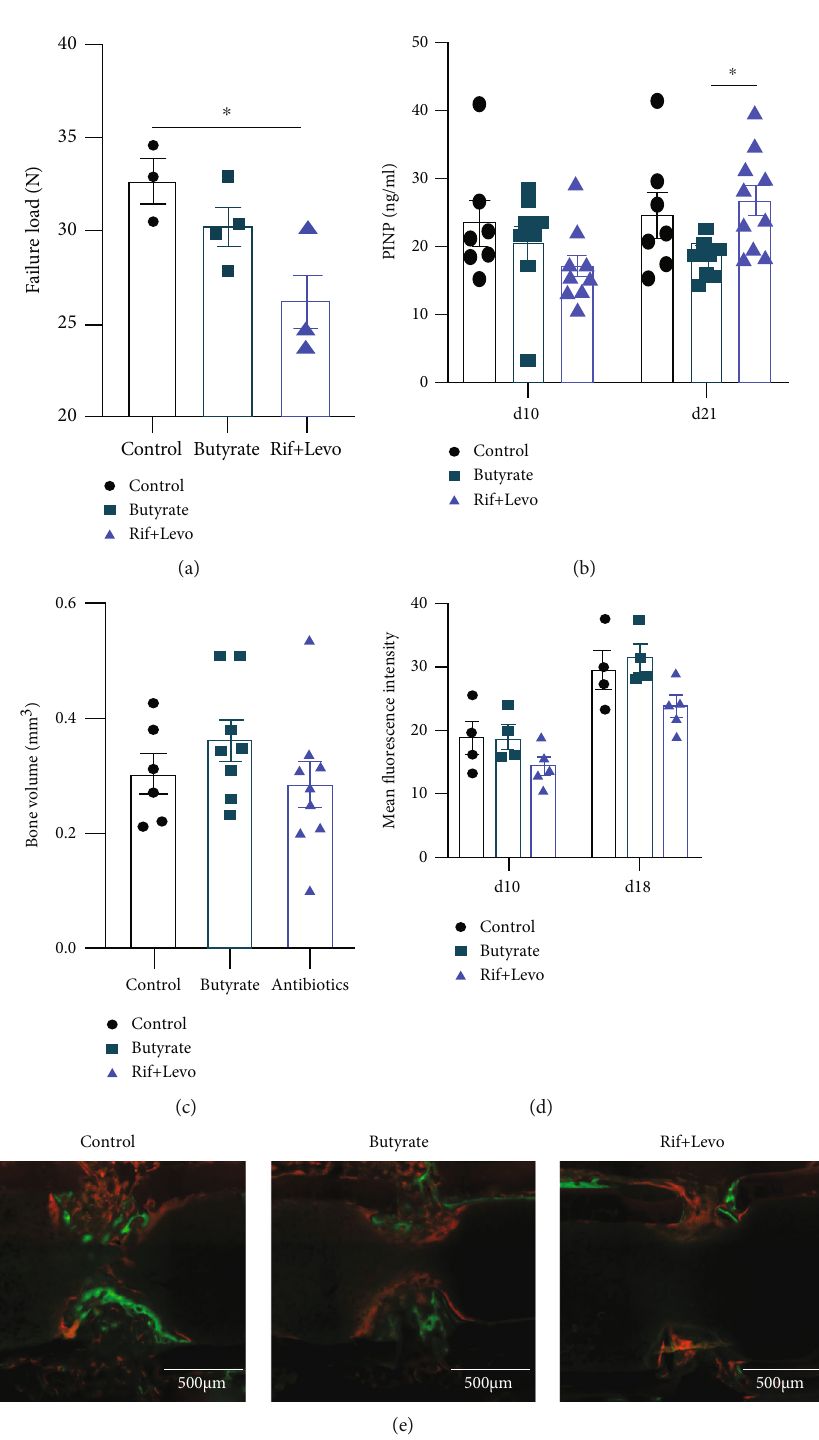
Figure 6: Butyrate does not signi fi cantly impact bone healing outcomes while rifampicin and levo fl oxacin may delay bone healing in a murine osteotomy model. Bone healing outcomes of operated mice were assessed 10 days, 18 days, and 21 days (euthanasia) following osteotomy. (a) Failure load of contralateral, unoperated femora was determined by a four-point-bending test. Data shown are means ð n = 3 ‐ 4 Þ ± SEM . (b) Procollagen type I C-terminal propeptide (PINP) in serum was determined 10 days and 21 days after osteotomy. Data shown are means ð n = 7 ‐ 10 Þ ± SEM . (c) Bone volume was measured by μ CT 21 days after osteotomy. Data shown are means ð n = 6 ‐ 10 Þ ± SEM . (d) Quanti fi cation of calcium deposition at osteotomy site 10 days after osteotomy (calcein green injection) and 18 days after osteotomy (xylenol orange injection). Data shown are mean fluorescent intensities ð n = 4 ‐ 5 Þ ± SEM . (e) Representative fl uorescent images showing calcein green and xylenol orange labelling of exposed calcium at osteotomy site. Scale bar = 500 μ m , ∗ p < 0 : 05